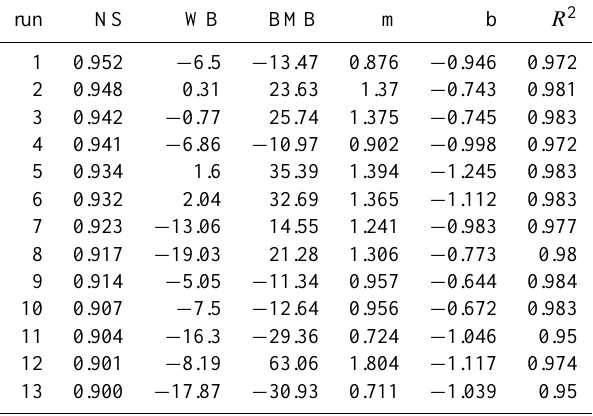
Table 3. Number of model run, Nash-Sutcliffe efficiency (NS) of hydrograph modelling, relative water balance error in % (WB), rel- ative error in bromide mass balance in % (BMB), the slope of the regression line fitted to the compared cumulative transport of mea- sured and modelled values (m), the intercept of the regression line (b) and the corresponding coefficient of determination ( R 2